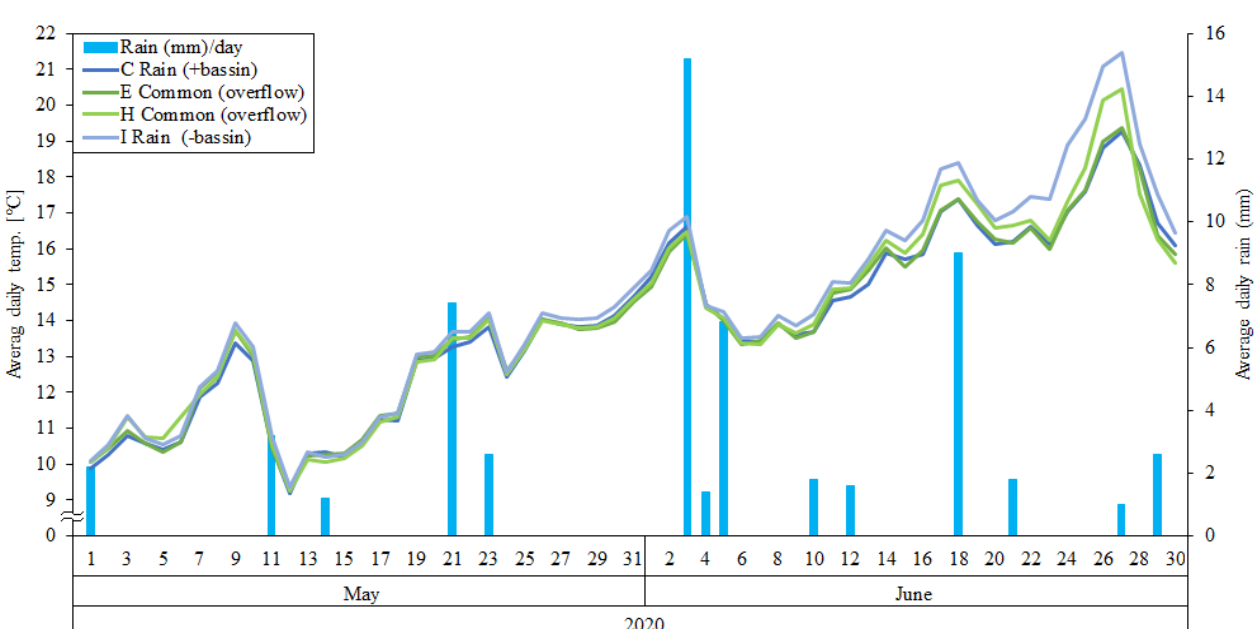
Figure 7. Variations in stream temperature [°C] downstream of specific outlet types during rain events [mm] (C: rain + basin, E & H: Common overflow and I: rain–basin). From the period May–June